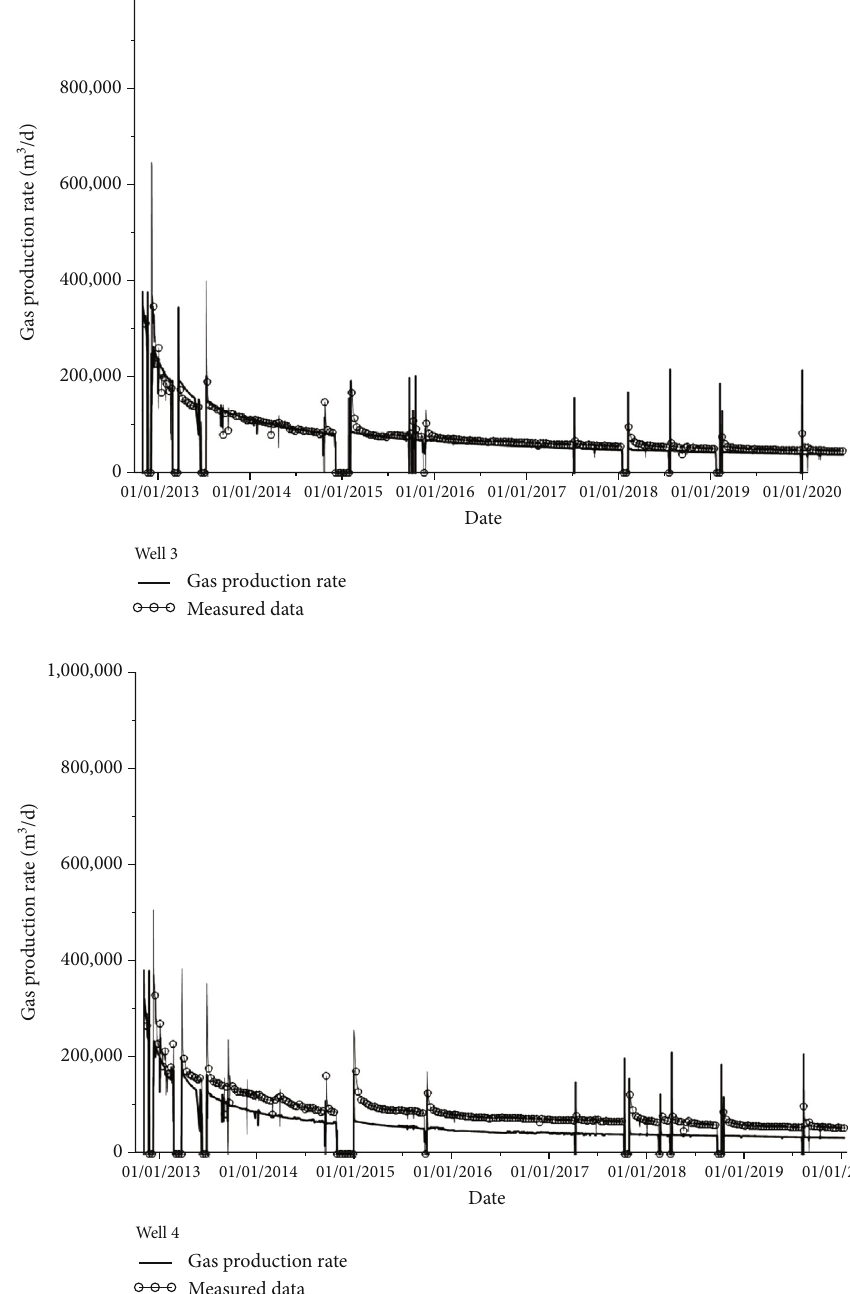
Figure 17: History matched results of gas production rates for wells 1 to